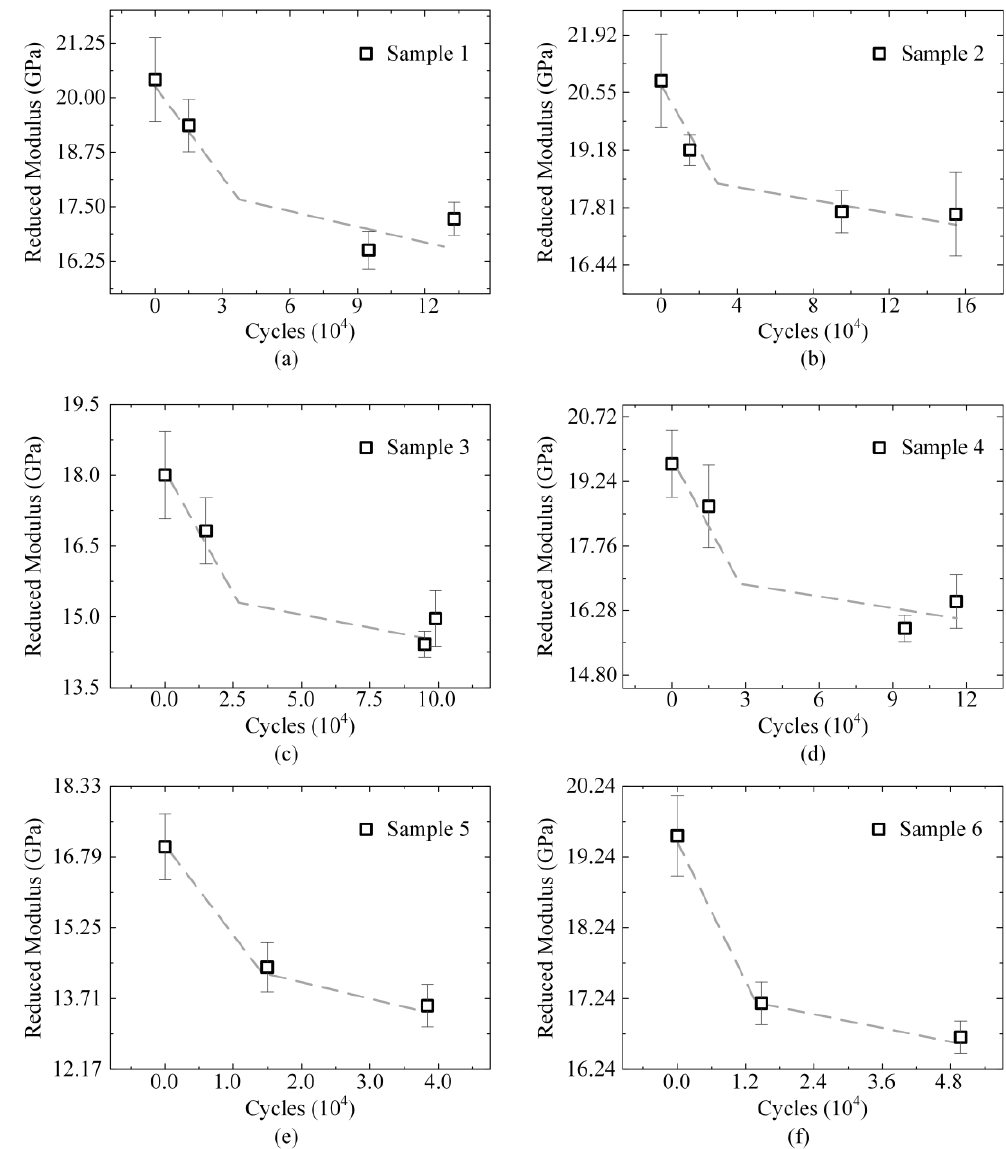
Figure 5. Evolutions of the reduced modulus in the adjacent region of each sample under four-point loading. ( a – d ) Reduced modulus of the samples subjected to four times of indentation tests; ( e , f ) Reduced modulus of the samples subjected to three times of indentation tests.